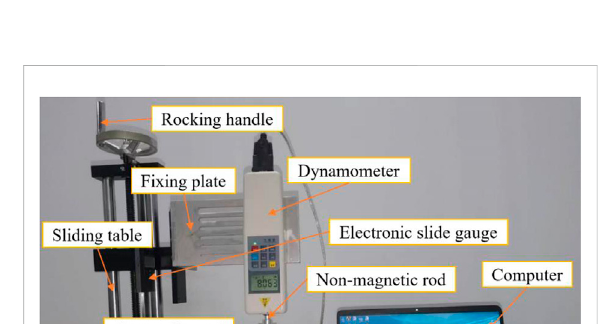
FIGURE 3 Appearanceviewofthevaryingstiffnessmagnetic fl uidshock absorber.